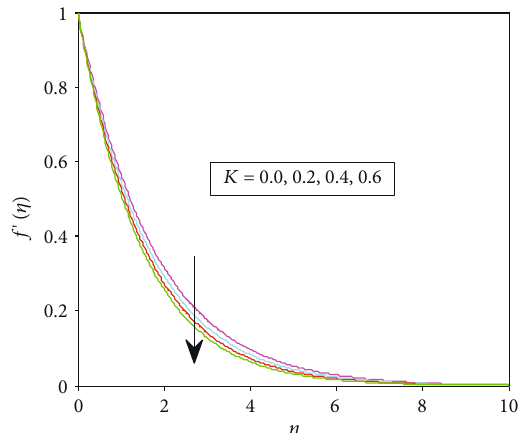
Figure 5: Velocity distribution for di ff erent values of N :